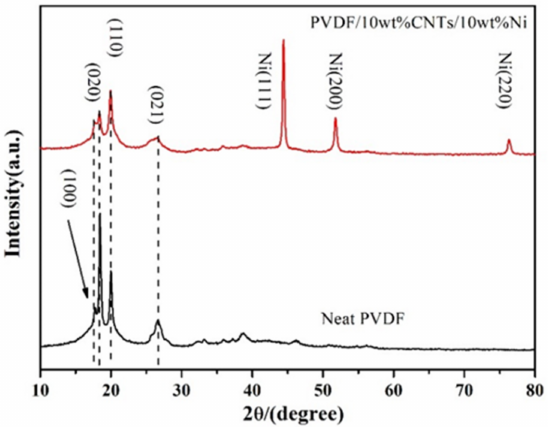
Figure 3. The XRD patterns of neat PVDF and PVDF/CNTs/urchin-like Ni